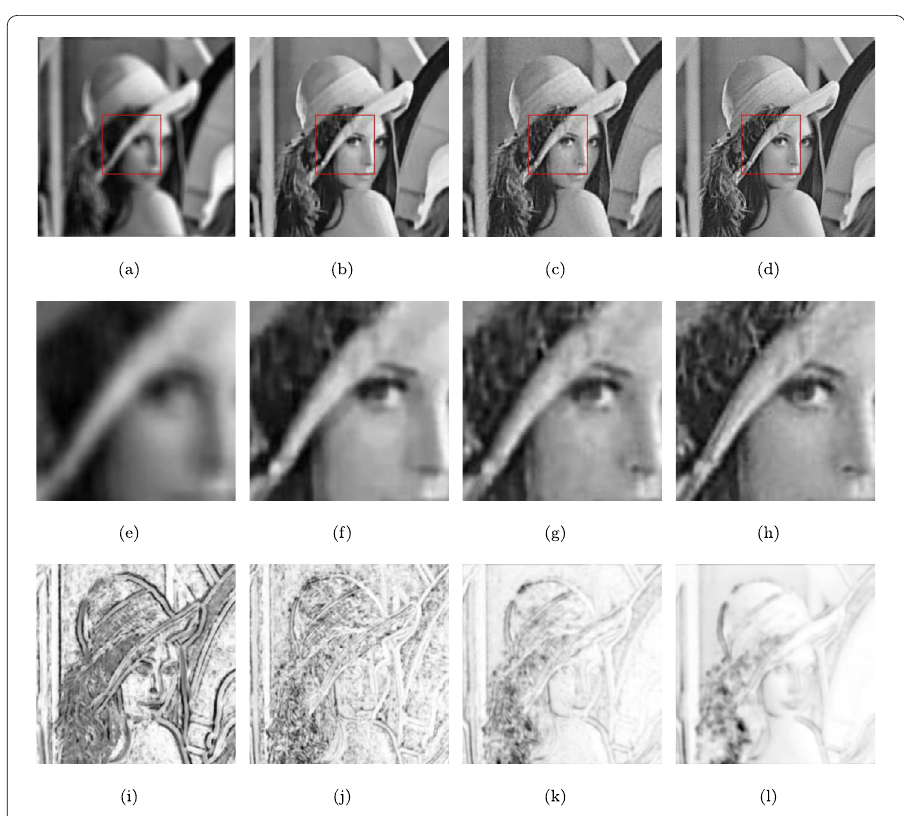
Figure 4 Results of different methods when restoring blurred and noisy image “Lenna” degraded by average blur with length 9 and a noise with BSNR = 35: ( a ) blurred and noisy image; ( b ) restored image by Fast-TV; ( c ) restored image by FNDTV; ( d ) restored image by our method; ( e ) zoomed part of ( a ); ( f ) zoomed part of ( b ); ( g ) zoomed part of ( c ); ( h ) zoomed part of ( d ); ( i ) SSIM index map of the corrupted image; ( j ) SSIM index map of the recovered image by FastTV; ( k ) SSIM index map of the recovered image by FNDTV; ( l ) SSIM index map of the recovered image by our method